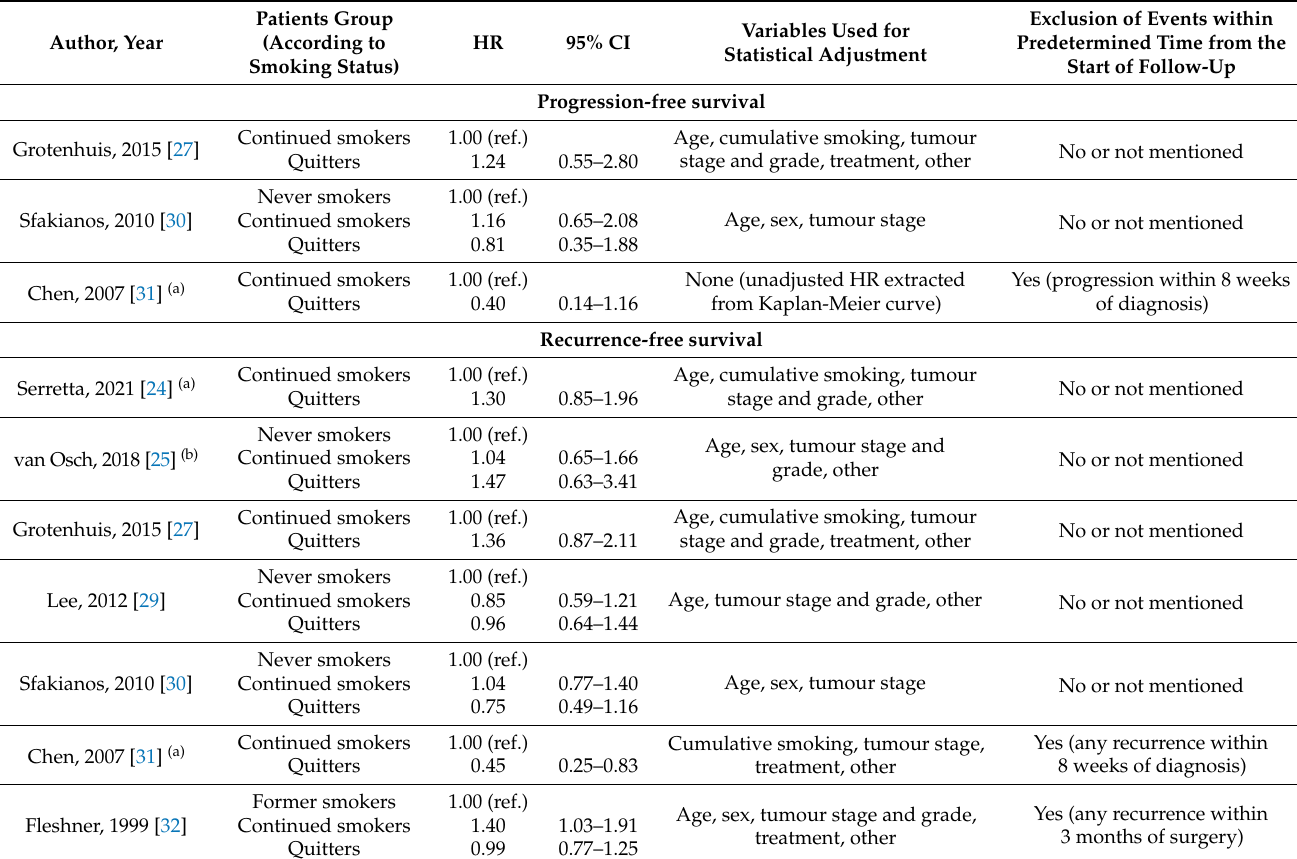
Table 4. Hazard ratio (HR), 95% confidence intervals (CI), and details of the statistical analysis for the association between at/around diagnosis smoking status (cessation/continuation) and bladder cancer recurrence-free and progression-free